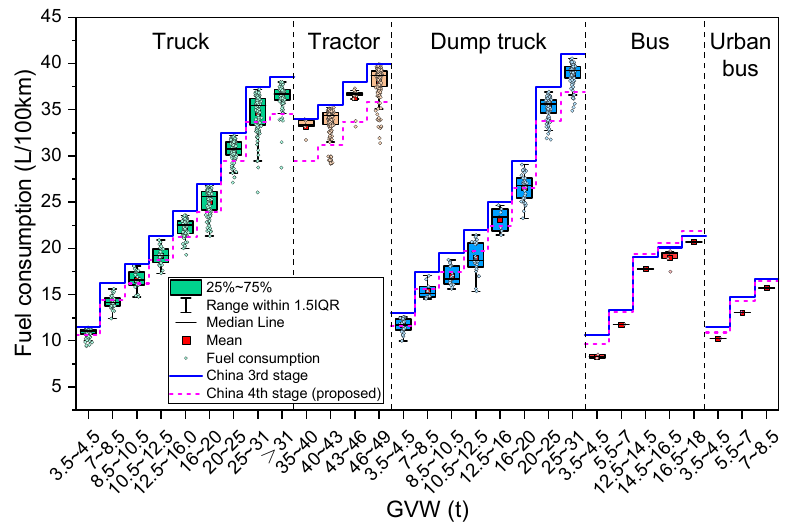
Figure 12. Fuel consumption distributions, and the China third and fourth stage limits.